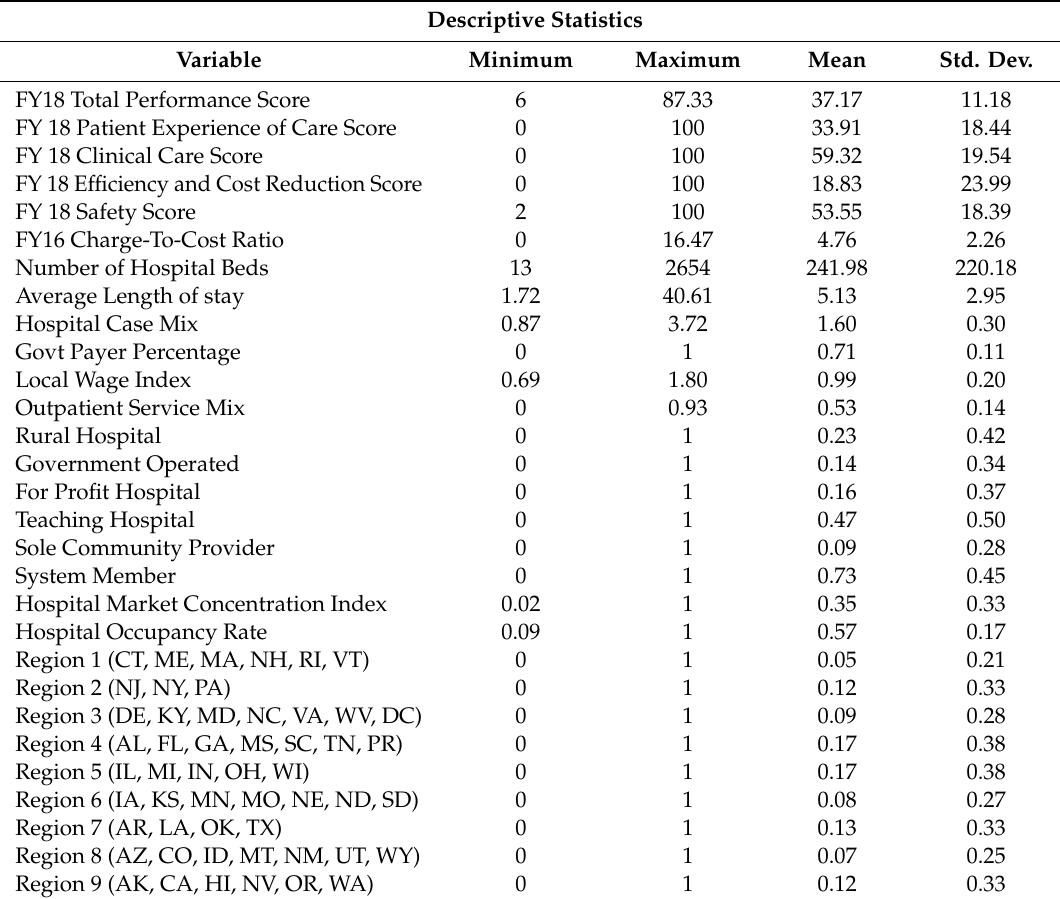
Table 1. Descriptive statistics of independent